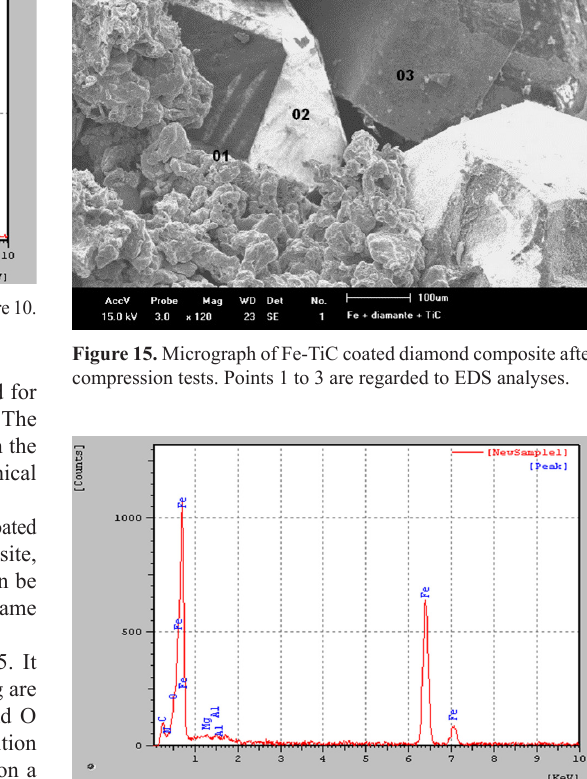
Figure 16. EDS analysis of TiC coated diamond in point 01 of Figure